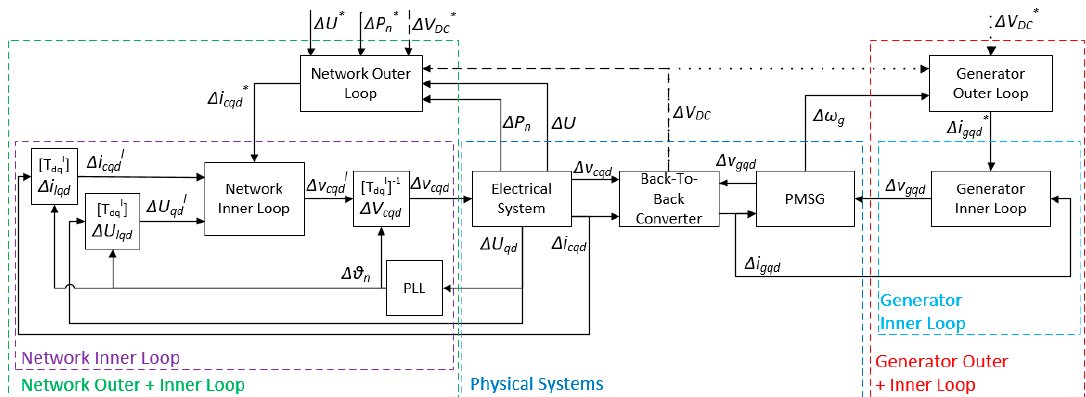
Figure 6. Linearised system for PLL ‐ based controllers. PMSG: Permanent Magnet Synchronous Generator.